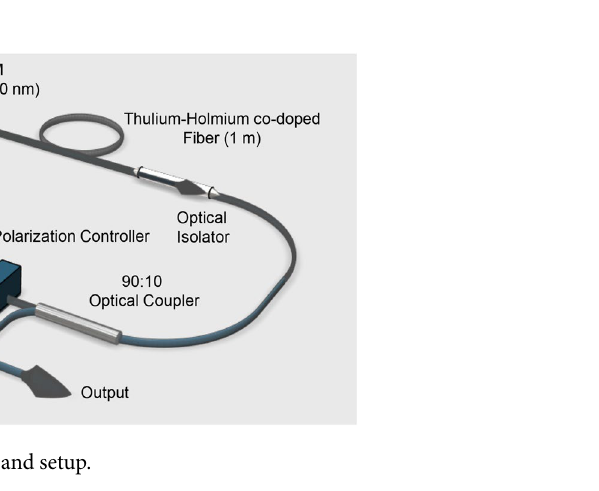
Figure 7. ( a ) Experimental setup for nonlinear transmission measurements and ( b ) the nonlinear transmission curve of the ReSe